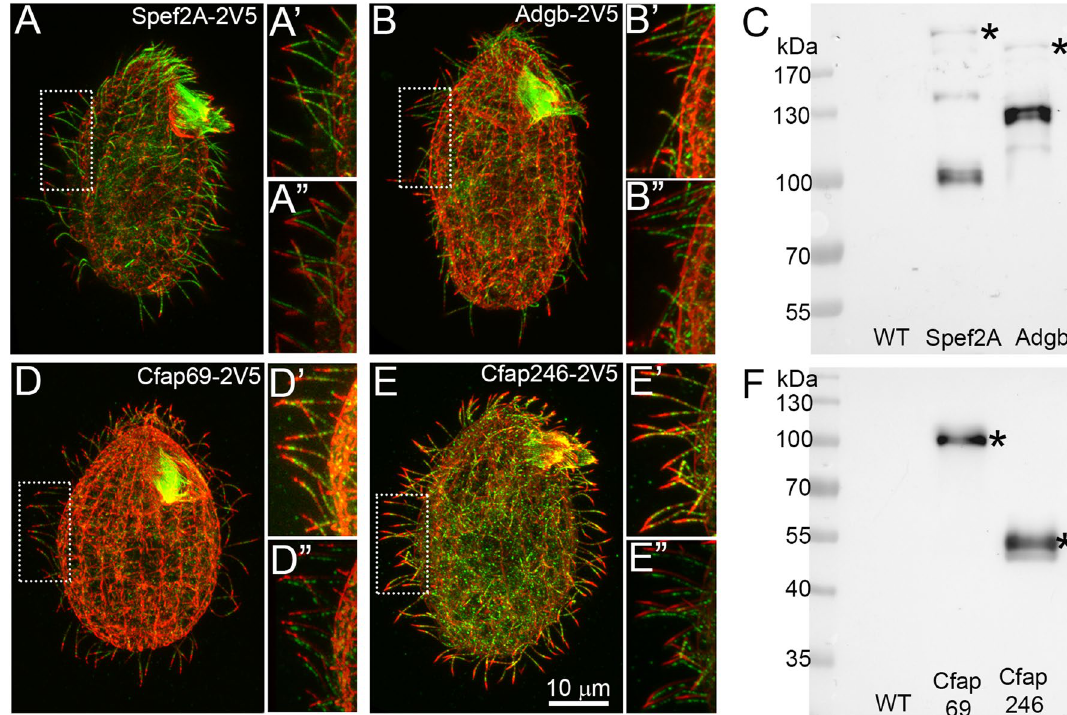
Figure 1. The components of the Tetrahymena C1b projection localize throughout the cilium except the cilium tip. ( A-B” ) and ( D–E” ) Merged immunofluorescence confocal images of Tetrahymena cells expressing Spef2A-2V5 ( A–A” ), Adgb-2V5 ( B–B” ), Cfap69-2V5 ( D–D” ) or Cfap246-2V5 ( E–E” ) under the control of the respective native promoters, double stained with anti-V5 (green) and anti-α-tubulin (red) antibodies. ( A’ , B’ , D’ , E’ ) A magnification of cilia marked with white insets in ( A , B , D ), and ( E ). ( A” , B” , D” , E” ) The images of the same areas as in ( A’ , B’ , D’ ) and ( E’ ) but the signal from a green channel was slightly shifted in respect to a red channel to better visualize that the ciliary tips are devoid of the fusion proteins. ( C , F ) Western blot analyses of 2V5-tagged fusions in cilia isolated from wild-type (WT) and mutant cells expressing: Spef2A-2V5 ( C ), Adgb-2V5 ( C ), Cfap69-2V5 ( F ) or Cfap246-2V5 ( F ) detected using anti-V5 antibodies. Band of the protein migrating according to the predicted molecular mass is marked by an asterisk.